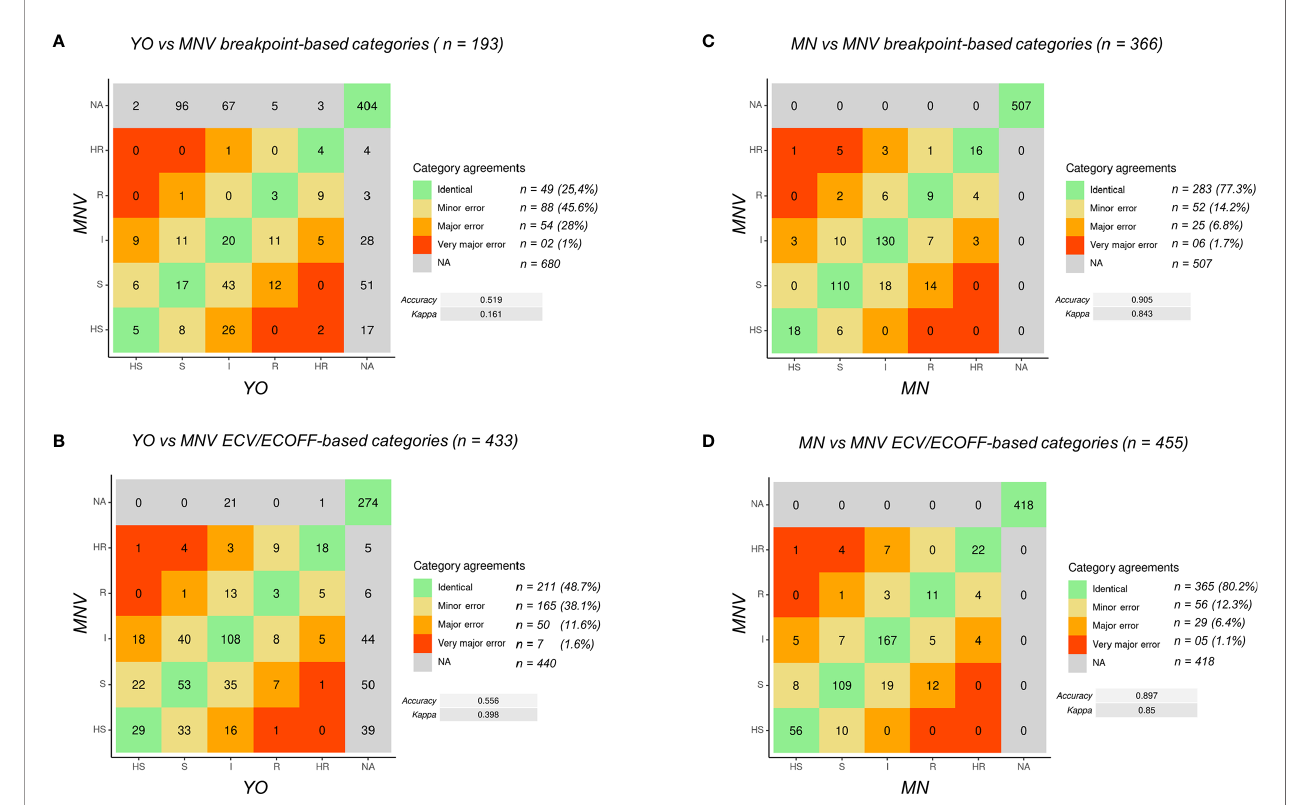
FIGURE 2 | Confusion matrix of MIC categories for all the data. (A) Comparison of YO versus MNV using breakpoints. (B) Comparison of YO versus MNV using ECV/ECOFF. (C) Comparison of MNV versus MN using breakpoints. (D) Comparison of MNV versus MN using ECV/ECOFF. VME, very major error (in red); ME, major error (in orange); mE, minor error (in yellow), NA, no analysis (in gray); no errors (in green). For each category of discrepancies, the number of event is indicated (n = xx) with the percent of possible comparisons it represents. Accuracy between the two methods and kappa score are indicated on the right side of the